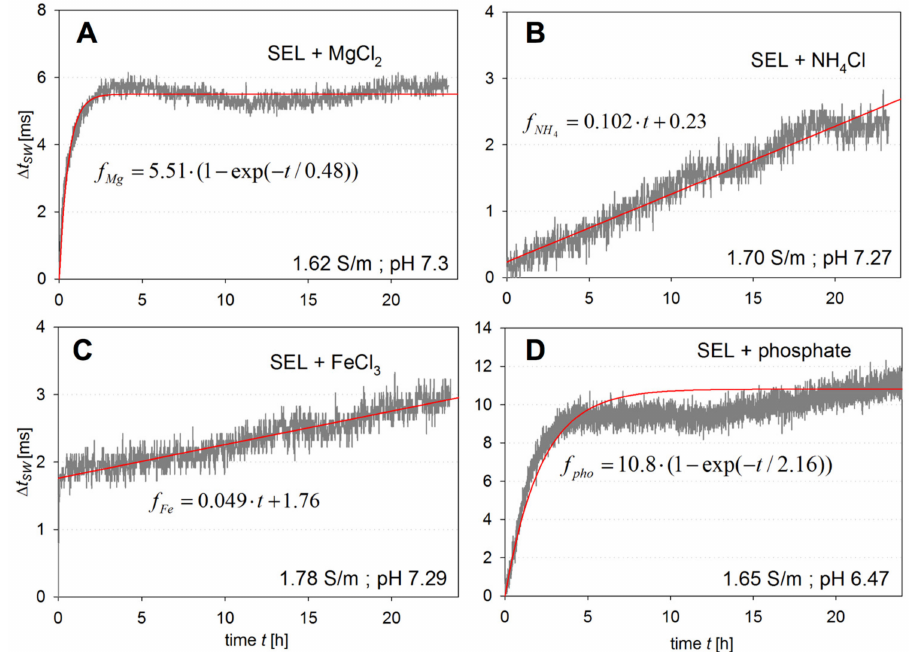
Figure 2. Difference in switching time ∆ t sw ( t ) during the observation period measured in SEL including the individual components of mineral salt (MS) medium: ( A ) MgCl 2 ; ( B ) NH 4 Cl; ( C ) FeCl 3 ; ( D ) phosphate buffer